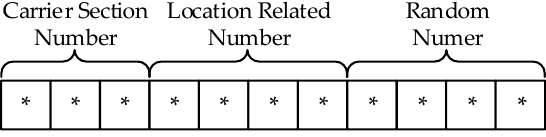
Figure 2. Structure of the mobile phone number in China.